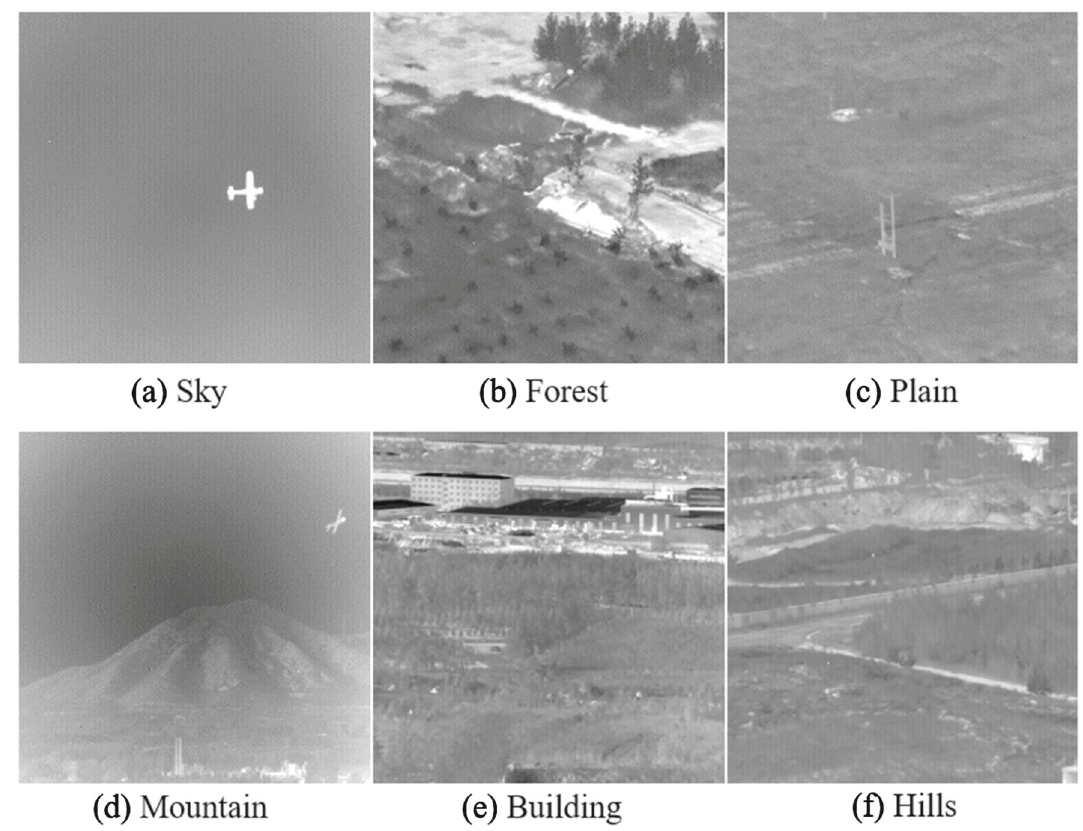
Fig. 5 Some examples from the employing dataset